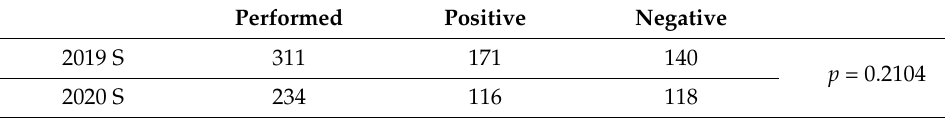
Figure 6. Stool cultures. Table 6. Mycological stool